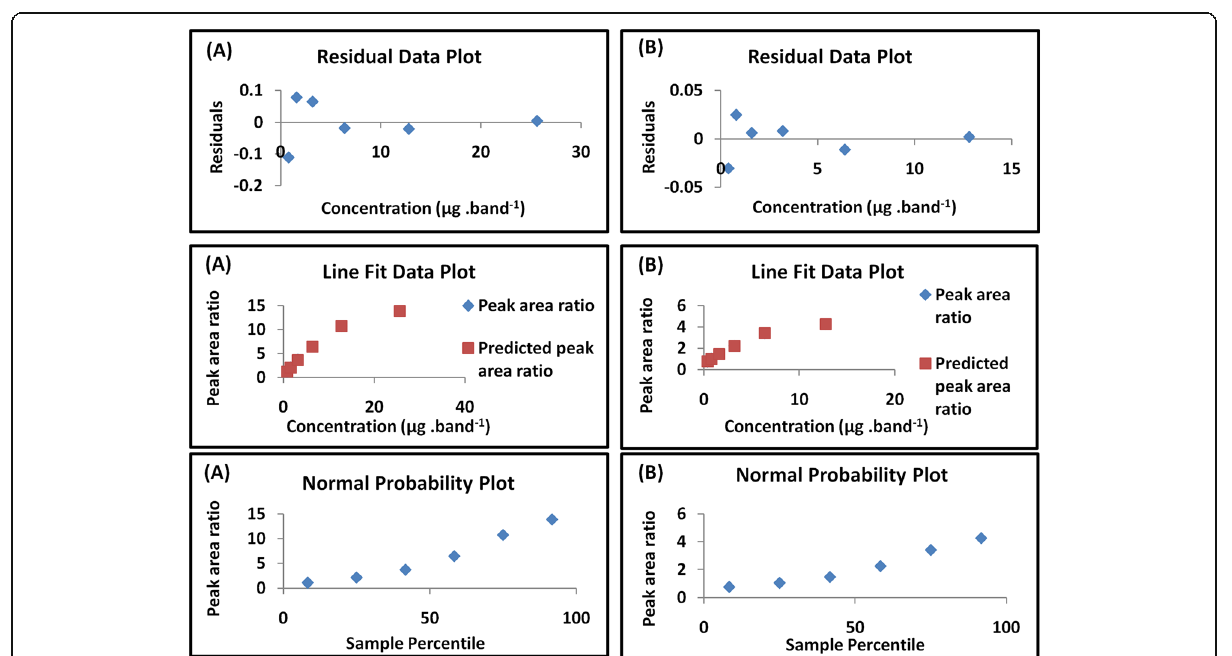
Fig. 5 Residual data plot, line fit data plot, and normal probability plot for SBR (a) and LPV (b) in HPTLC-densitometric